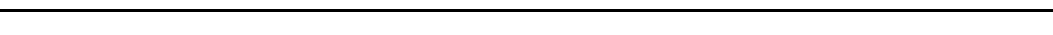
Fig. 6 lapsyn controls astrocyte-like mng branch formation and positioning during development. Clones were generated using ey-FLP MARCM and visualized with loco 1.3D2 -Gal4 UAS-cd8GFP ( green ). Repo-labeled glial nuclei ( red ). a – f Assessment of branch formation. Unlike in controls, lapsyn ZG1 mng extended reduced branches into the neuropil ( arrowheads ) or ectopic branches between glial cell bodies at the neuropil border ( arrows ) at 55 and 60 h APF. Defects persisted in adults. g – l Assessment of positioning. Compared to controls, more lapsyn ZG1 mng cell bodies were detected in the cortex at 30 and 42 h than at 24 h APF ( arrows ). These sent long protrusions to the neuropil border. mng at the border extended long processes into the cortex ( i , double arrowhead ). Quanti fi cations assessing numbers of GFP-positive mng ( m ) and percentages in the cortex of control and lapsyn ZG1 mosaics ( n ) during metamorphosis. Scatter plots with bars show data points and means ± 95% con fi dence intervals ( n = 20- μ m stacks of optical sections from 19,27,6,12,18,21,22,12,13,13,19, and 23 ( m ) and 19, 27, 6, 12, 18, 19, 22, and 12 optic lobes ( n ). m Unpaired, two-tailed Student ’ s t- test not assuming equal variance: P = 0.0129, P = 0.0678, P = 0.0001, P = 5.47 × 10 − 5 , P = 4.38 × 10 − 7 , P = 2.03 × 10 − 12 . n Two-tailed Mann-Whitney U -test corrected for ties: P = 0.0557, P = 0.0002, P = 4.0 × 10 − 7 , P = 0.0010. o , p Dcp1 ( blue ) labeling reveals that control ( o ) and lapsyn ZG1 ( p ) mng in the cortex undergo apoptosis ( arrows ) at 42 h APF. q Comparison of percentages of control and lapsyn ZG1 clones in the cortex ( left ) and Dcp1-positive clones in the cortex and at the neuropil border ( right ) at 42 h APF. Scatter plots with bars show data points and means ± 95% con fi dence intervals ( n = 20- μ m stacks from 21, 29 ( left ), 21, 29, 21, 11, 28, and 26 optic lobes). Two-tailed Mann-Whitney U -test corrected for ties: P = 2.4 × 10 − 7 , P = 0.0016, P = 0.0029, P = 0.0025. NS not signi fi cant, * P < 0.05, ** P < 0.01, *** P < 0.001, **** P < 0.0001. Panels a – l show projections. For genotypes, sample numbers and additional statistical values, see Supplementary Tables 1 and 2. Scale bars , 50 μ